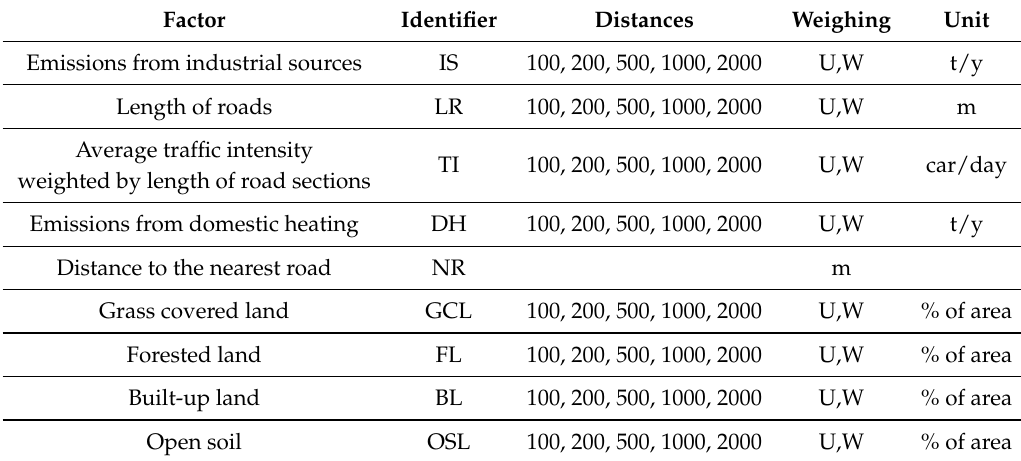
Table 2. Factors of pollution sources, factors of land